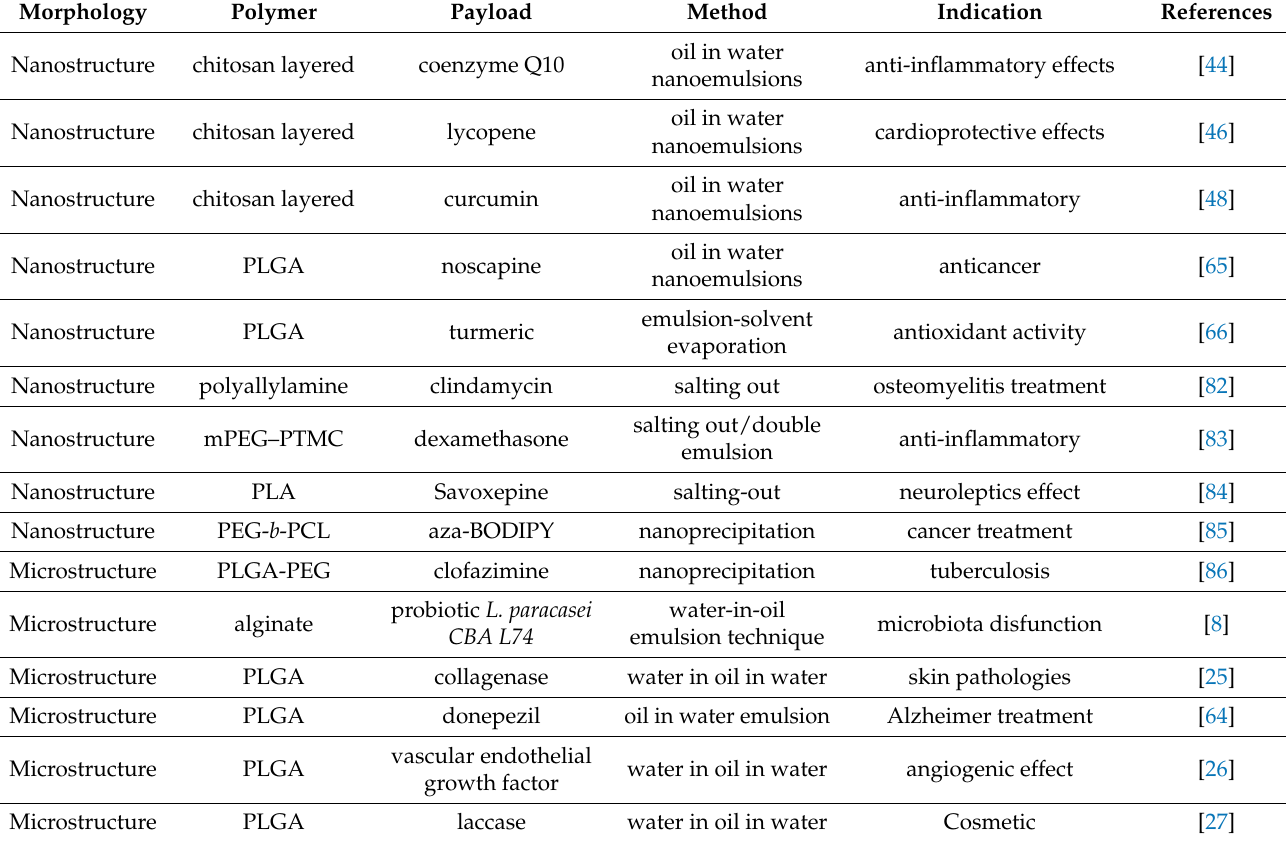
Table 1. Overview of encapsulation methods for the preparation of drug loaded nano/microcarriers.